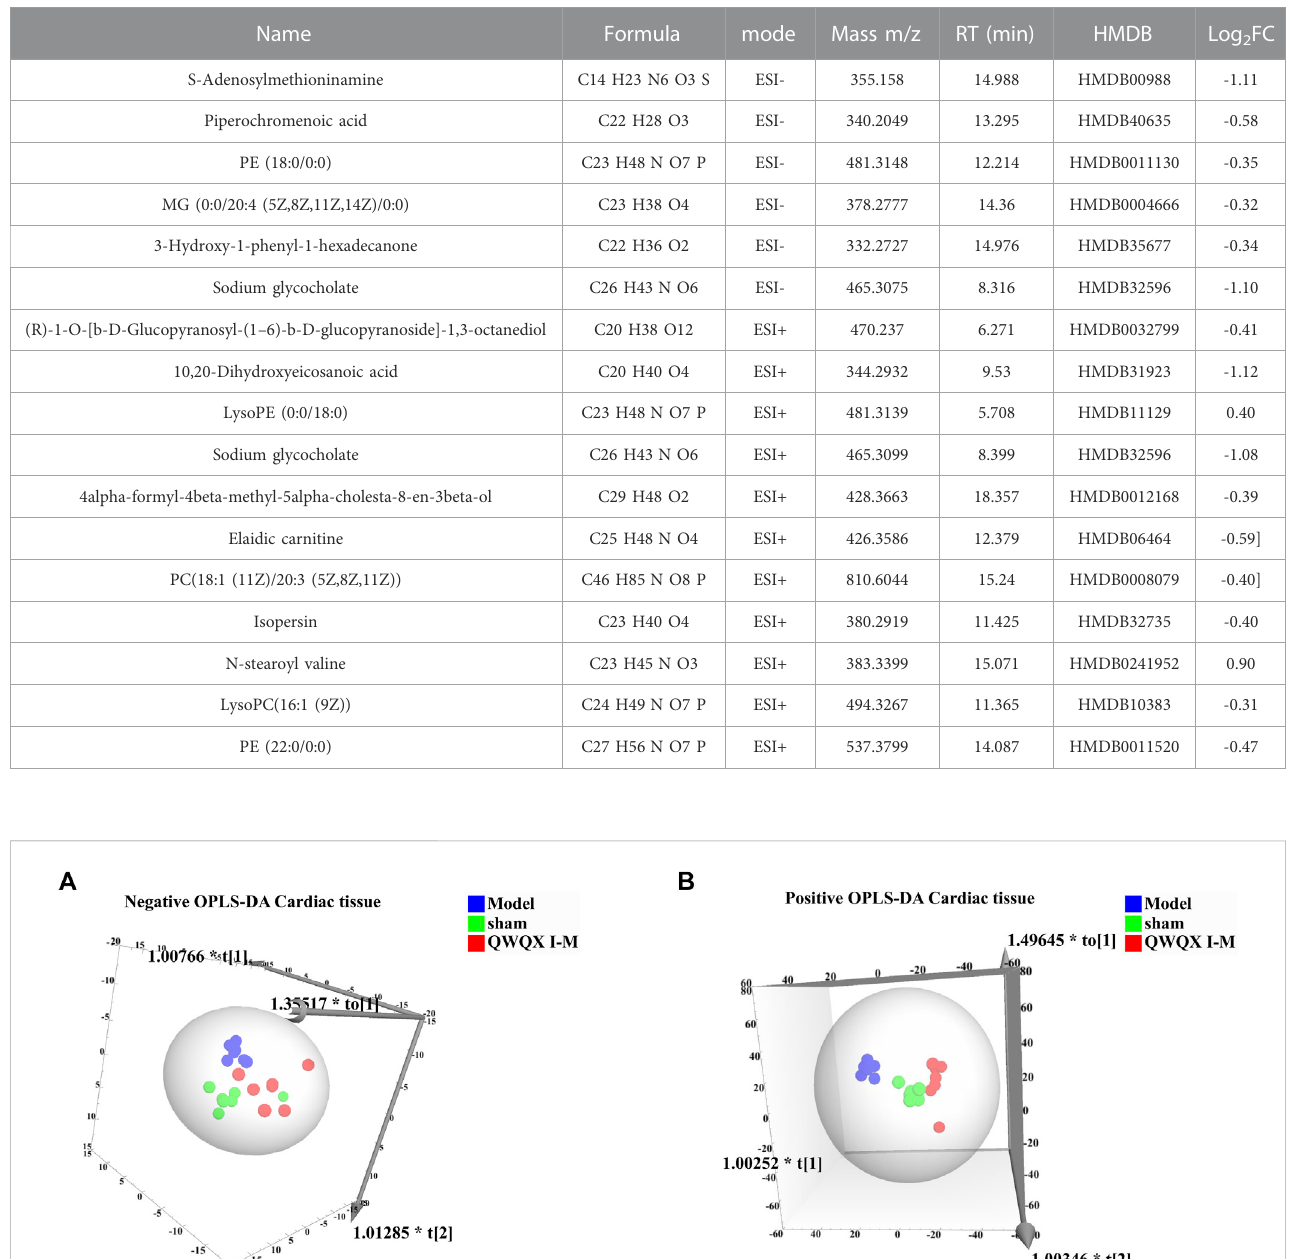
TABLE 4 Differential metabolites of QWQX I anti-chronic heart failure-related rat plasma ( p < 0.05).